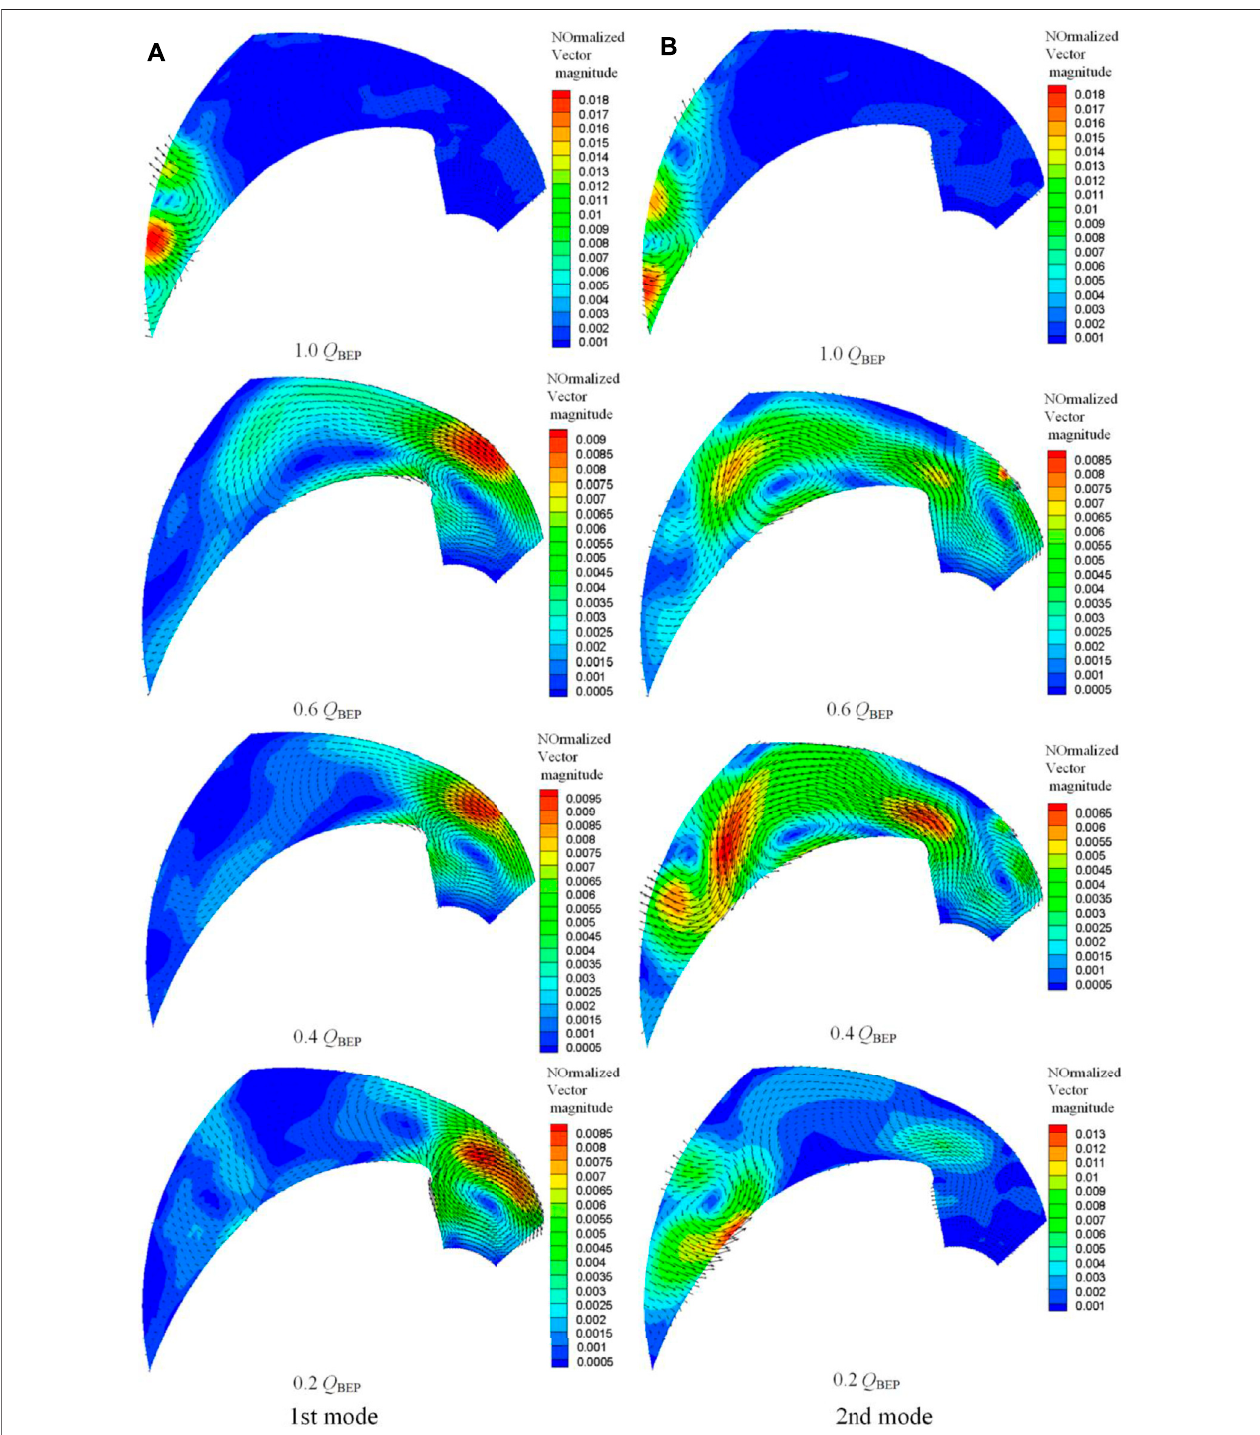
FIGURE 7 | The vector plots of the fi rst and second modes for different fl ow rates. (A) First mode, (B) second mode.